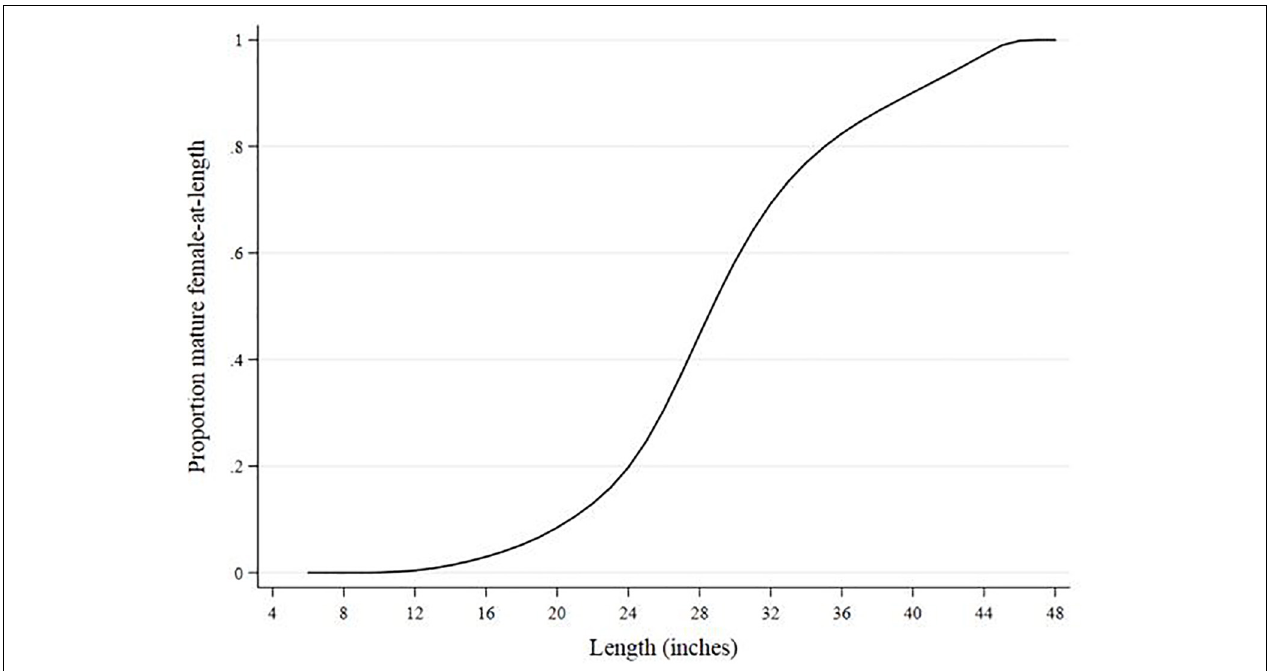
FIGURE 6 | 2015 striped bass proportions mature